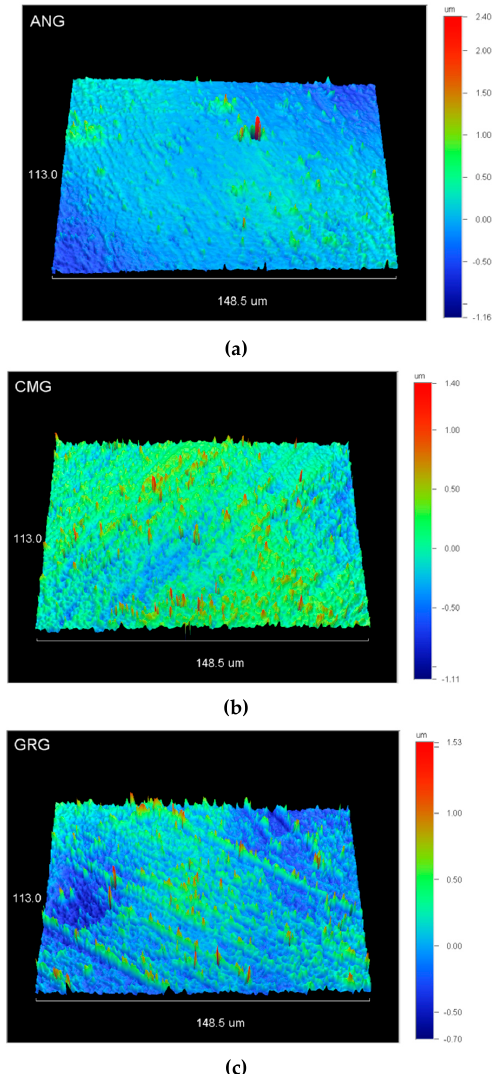
Figure 5. 3D-profilometric images of ( a ) ANG (a, z-scale: − 1.14~2.4 μ m), ( b ) CMG (b, z-scale: − 1.11~1.4 μ m) and ( c ) GRG (c, z-scale: − 0.7~1.53 μ m) at 40× magnification.